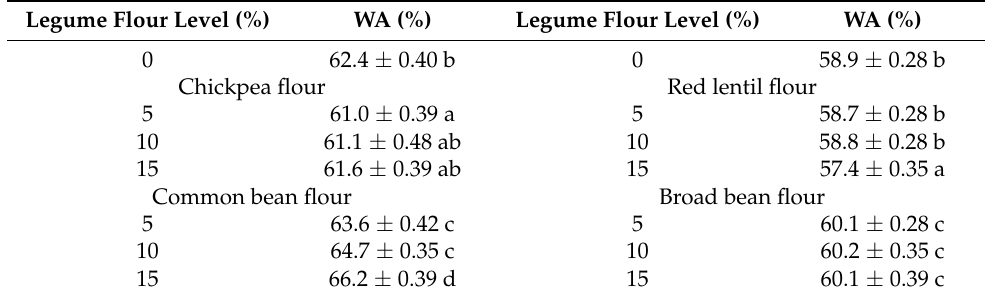
Table 4. Effect of legume flours on water